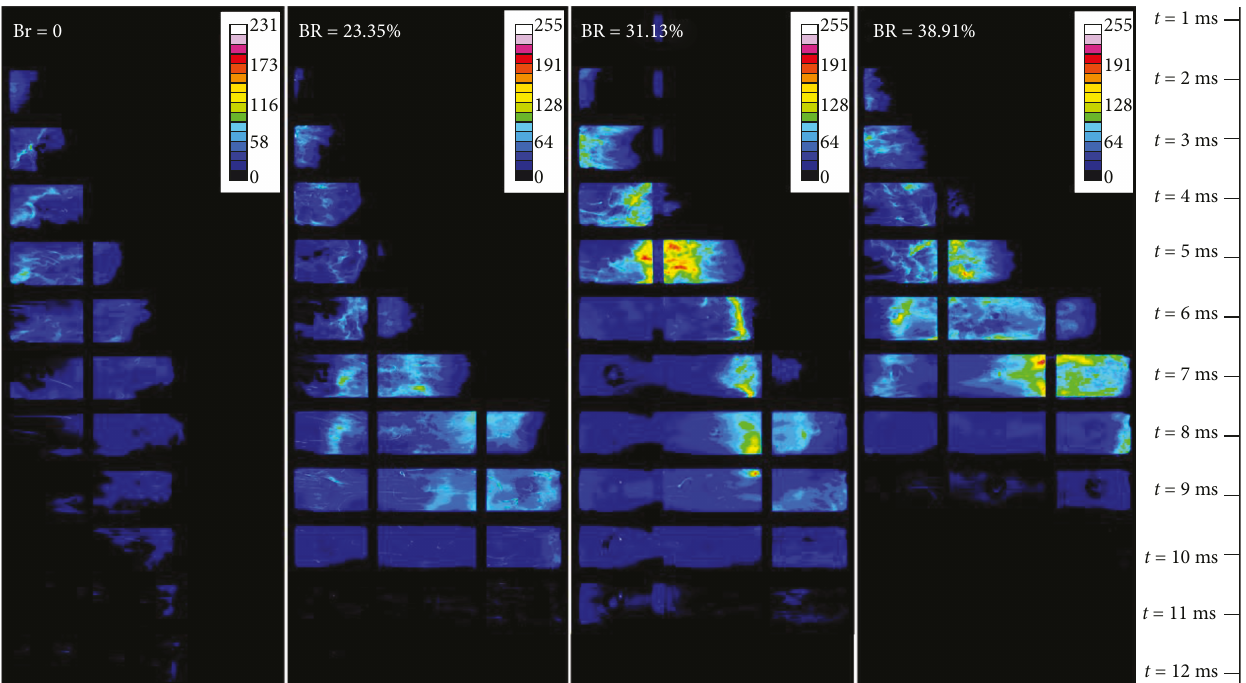
Figure 15: Flame propagation characteristics in the WRC with spoilers of di ff erent blockage